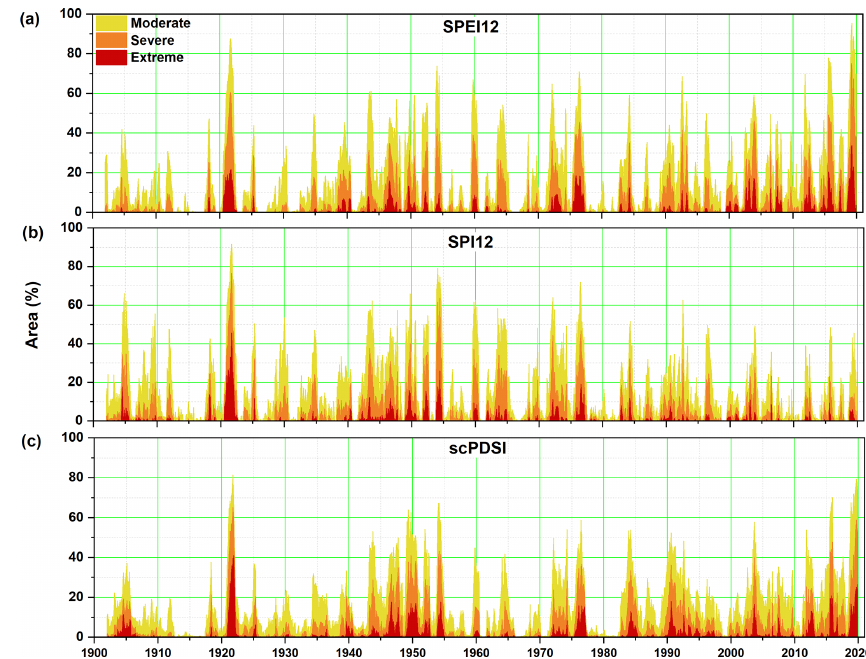
Figure 3. Temporal evolution of the percentage area affected by droughts over CEU for the (a) SPEI12, (b) SPI12, and (c) scPDSI for three drought severity categories: moderate (yellow), severe (orange), and extreme (dark red). See text for the definition of the drought